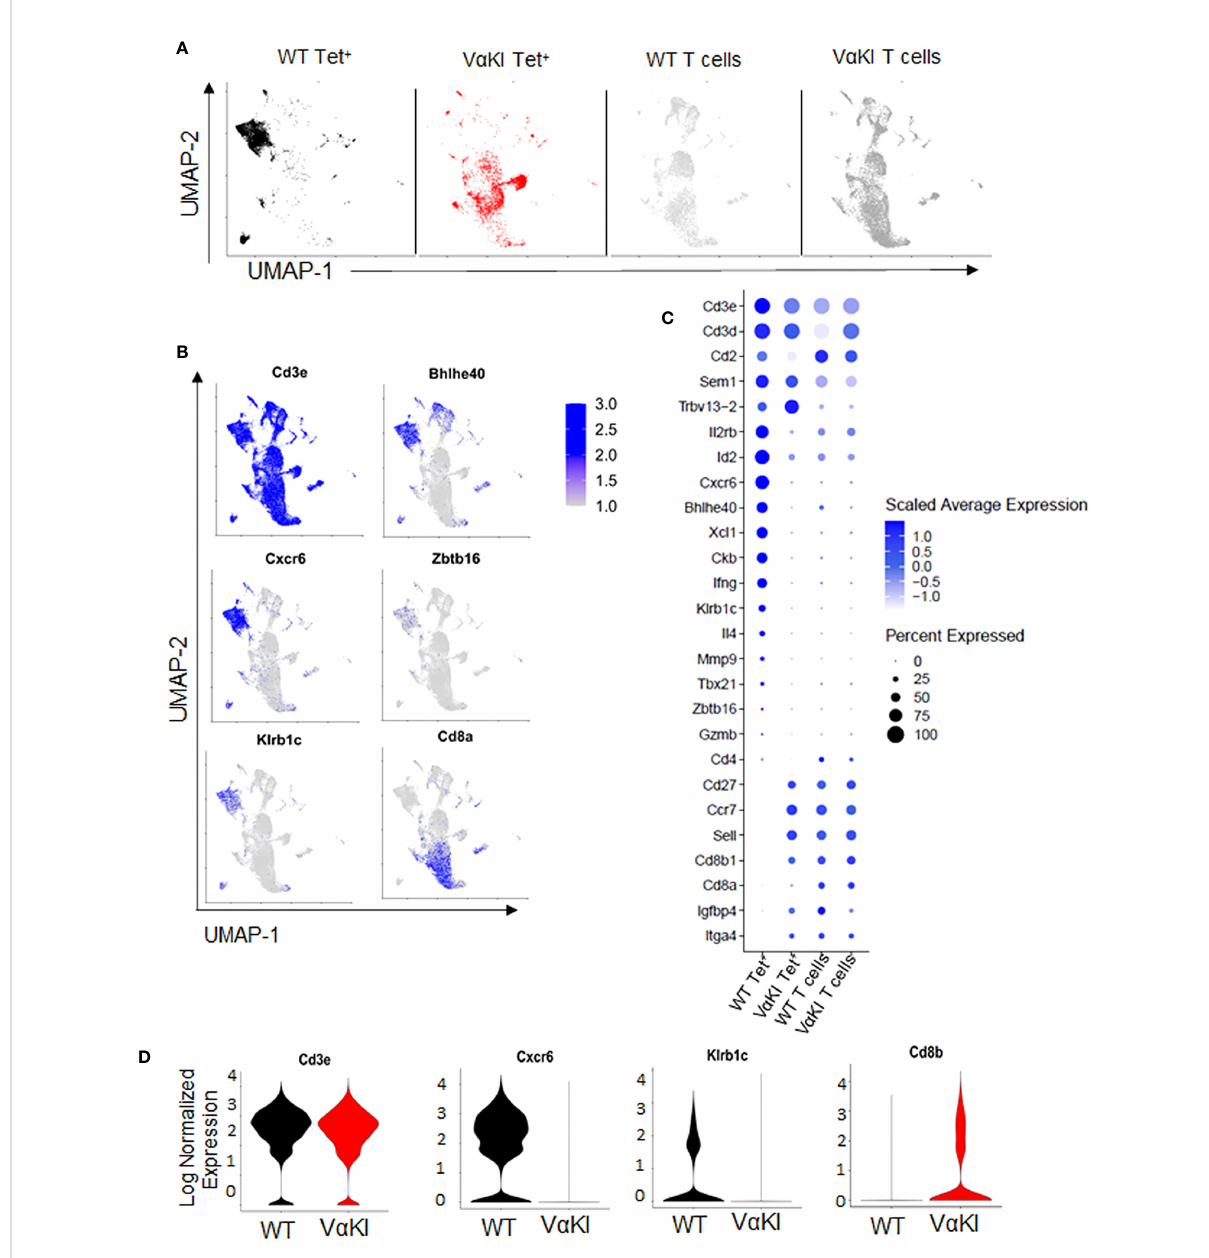
FIGURE 3 Gene expression pro fi le of CD1d tetramer binding cells in V a KI mice. (A) UMAP plots showing analysis of single-cell mRNA sequencing data from spleen cells previously sorted for CD1d tetramer binding (Zombie negative, B220 negative, TCR b +, CD1d Tet+) of C57BL/6 (WT) mice in black and V a KI in red. T cells not binding CD1d tetramers, representing predominantly conventional MHC-restricted T cells (Zombie negative, B220 negative, TCR b +, CD1d Tet negative), are in gray). (B) mRNA expression of aggregated samples and their localization on the UMAP plots showing expression levels of selected genes with documented expression in WT mouse iNKT cells, including genes for CD3 epsilon subunit (Cd3e), CXCR6, NK1.1 (Kirb1c), CD8 a , and transcription factors Bhlhe40 and PLZF (Zbtb16). Intensity of blue shading correlates positively with transcript expression level. (C) Bubble plots showing expression levels of transcripts for 26 genes selected for differential expression by Tet+ versus conventional (Tet negative) T cells. Blue shading indicates average expression level per cell, and size of symbols proportional to percentage of cells expressing detectable transcript levels. (D) Violin plots of mRNA expression of Cd3e, Cxcr6, Klrb1c and Cd8b in CD1d tetramer binding cells (Zombie and B220 negative, TCR b + and CD1d-Tet+) from WT (C57BL/6) and V a KI mice. All plots based on data from 4367 CD1d Tet+ cells from WT, 3403 Tet+ cells from V a KI, 6862 T cells from WT and 10998 T cells from V a